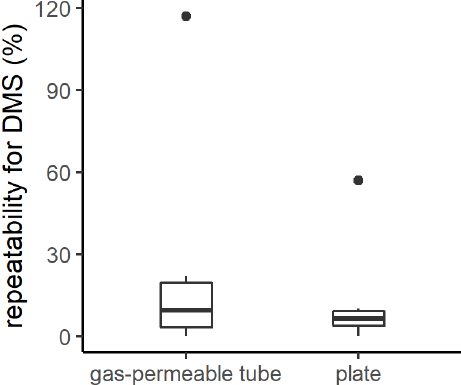
Figure 2. Box plot of the repeatability for DMS measurements with the gas-permeable tube and the plate. The box plot represents the distribution of the data, with the box corresponding to the interquar- tile range and the bold horizontal line the median. The limits of the vertical lines represent the upper and lower fences. The outliers are represented by points outside the